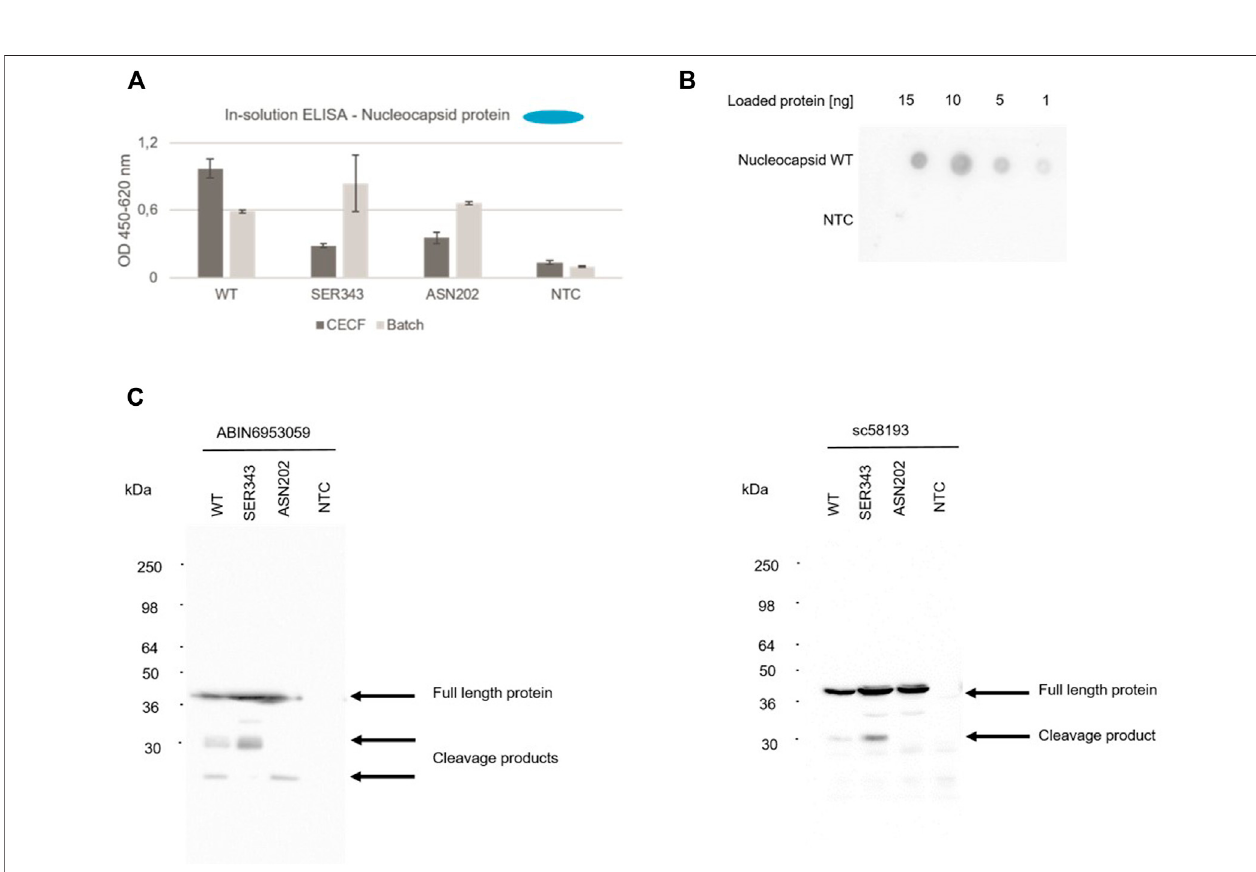
FIGURE 6 | Detection of N protein. The nucleocapsid WT protein as well as both mutants (SER343 and ASN202) were synthesized in a CHO cell-free system. Detection of cell-free synthesized nucleocapsid protein in an in-solution ELISA (A) , a Dot Blot (B) and Western Blots (C) .